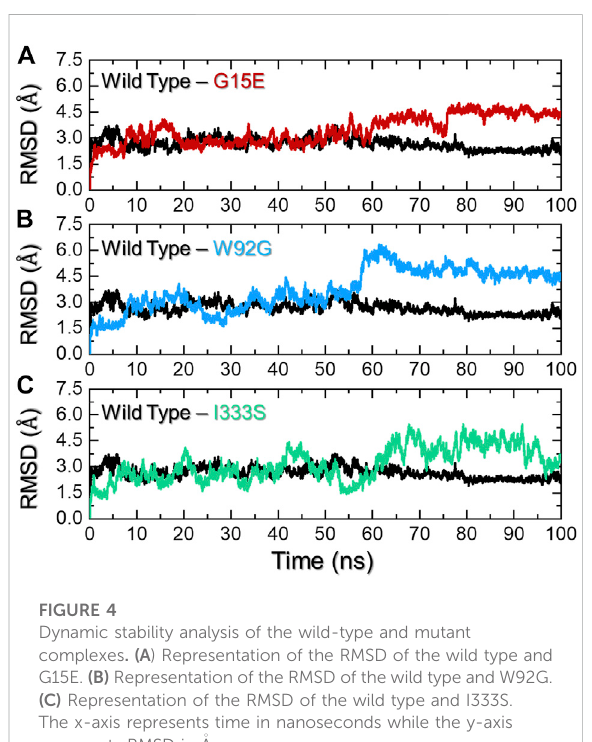
FIGURE 4 Dynamic stability analysis of the wild-type and mutant complexes . (A ) Representation of the RMSD of the wild type and G15E. (B) Representation of the RMSD of the wild type and W92G. (C) Representation of the RMSD of the wild type and I333S. The x-axis represents time in nanoseconds while the y-axis represents RMSD in (cid:1) A.